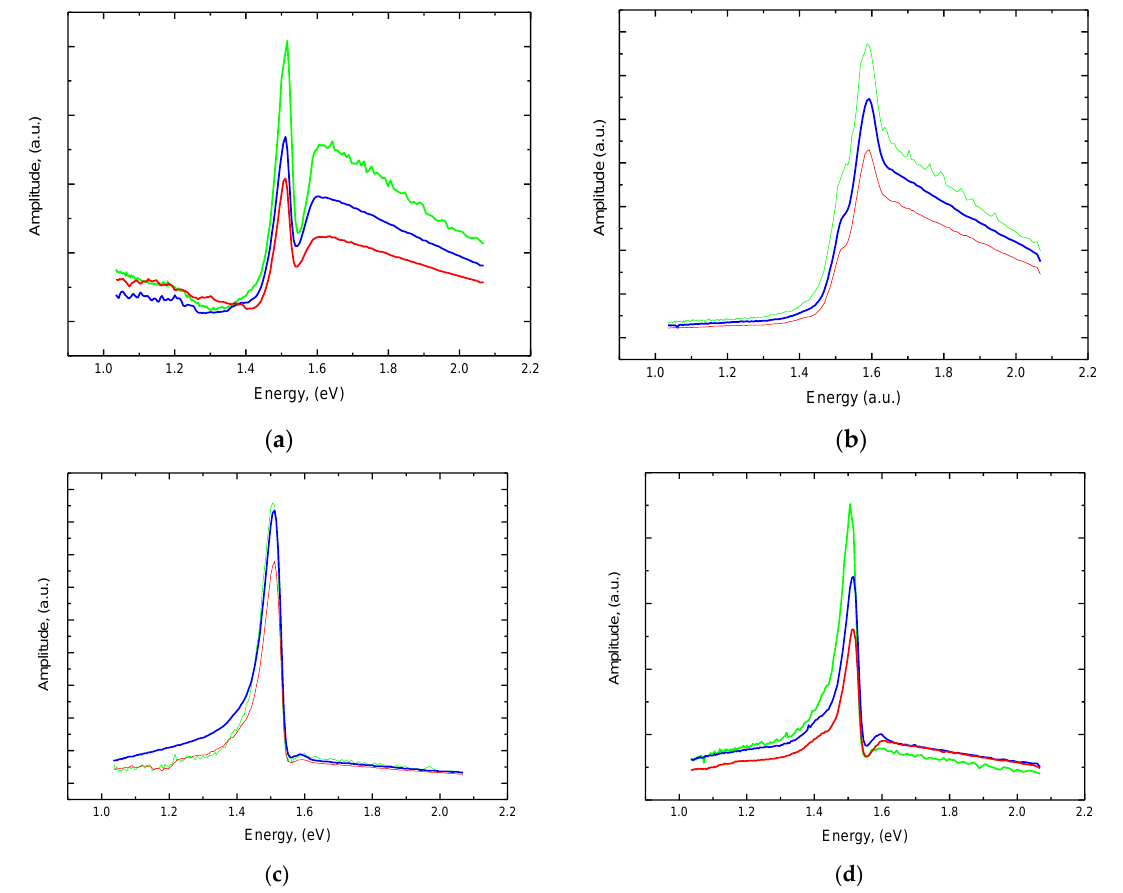
Figure 7. Amplitude spectra of Cd 0.95 Be 0.05 Te for front and rear detection and illumination of different surfaces at 12 Hz (blue lines), 76 Hz (green lines), and 126 Hz (red lines). ( a ) Surface 1 illuminated, rear detection. ( b ) Surface 1 illuminated, front detection. ( c ) Surface 2 illuminated, rear detection. ( d ) Surface 2 illuminated, front detection.